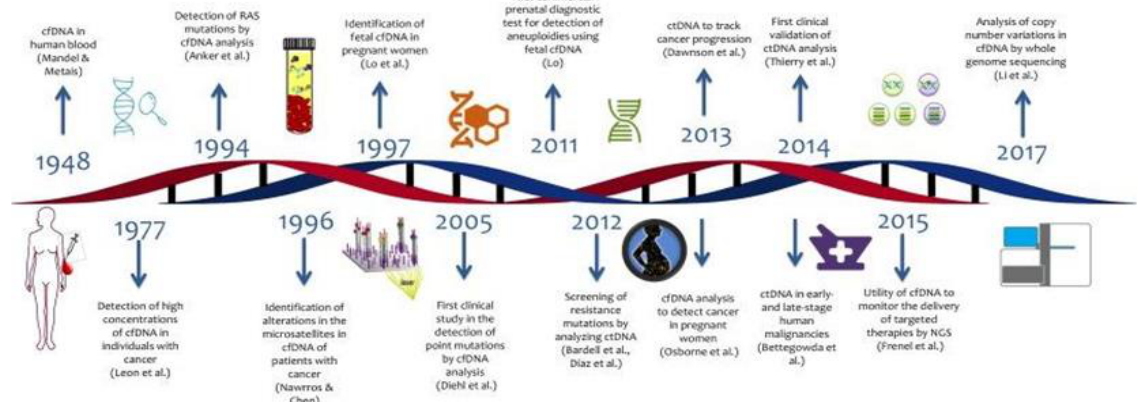
Figure 1. The development of liquid biopsy from time to time